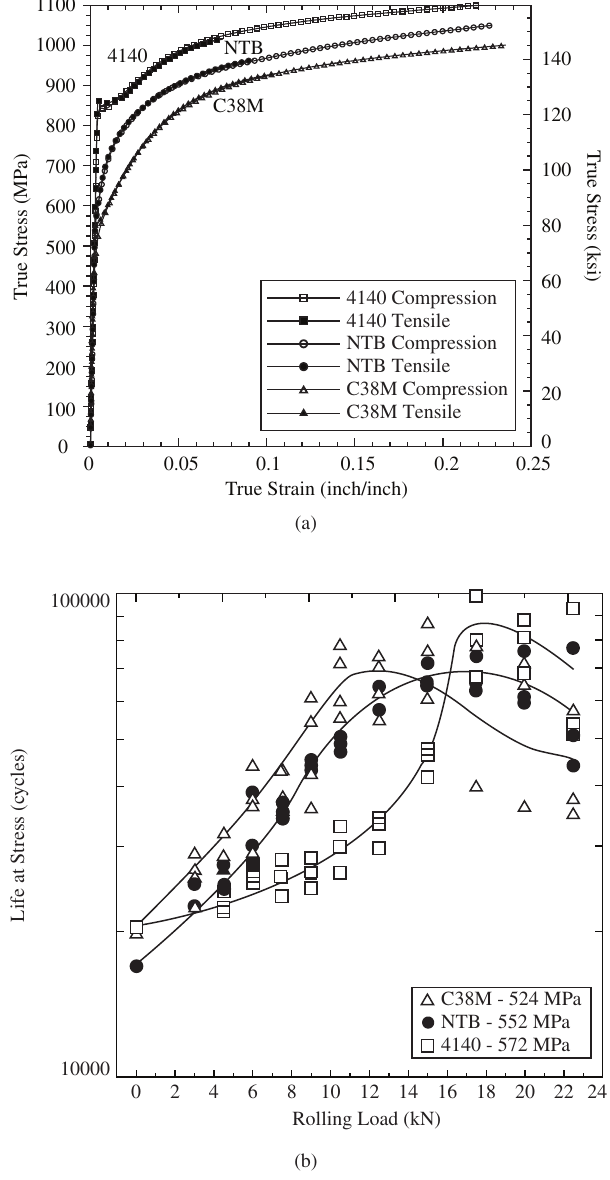
Figure 5. Light optical micrographs showing the effects of Nb additions on the prior austenite grain size formed in a Ti-modified steel annealed for 240 min at 1000 °C, a) 0.02 Nb; b) 0.06 Nb; and c) 0.1 Nb, all compositions in wt. (%) 20 .